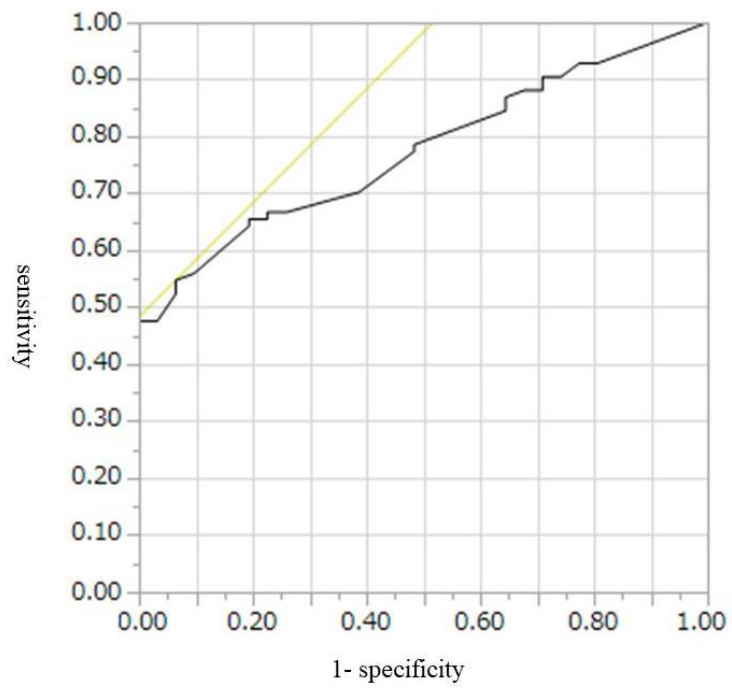
Figure 3. Receiver operating characteristics curve of the presence of mural lesions on conventional EUS for the diagnosis of malignant IPMN. EUS, endoscopic ultrasonography; IPMN, intraductal papillary mucinous neoplasm.